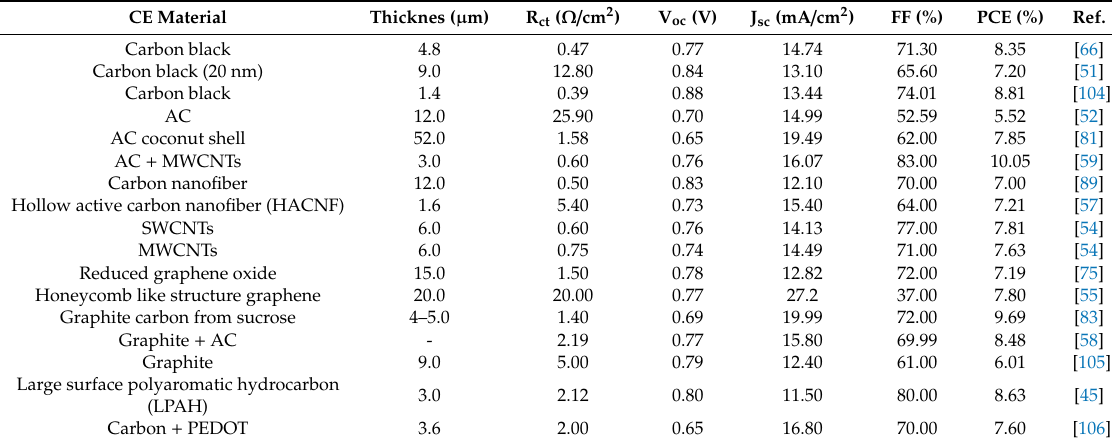
Table 3. Photovoltaic parameters of DSSCs based on carbonaceous